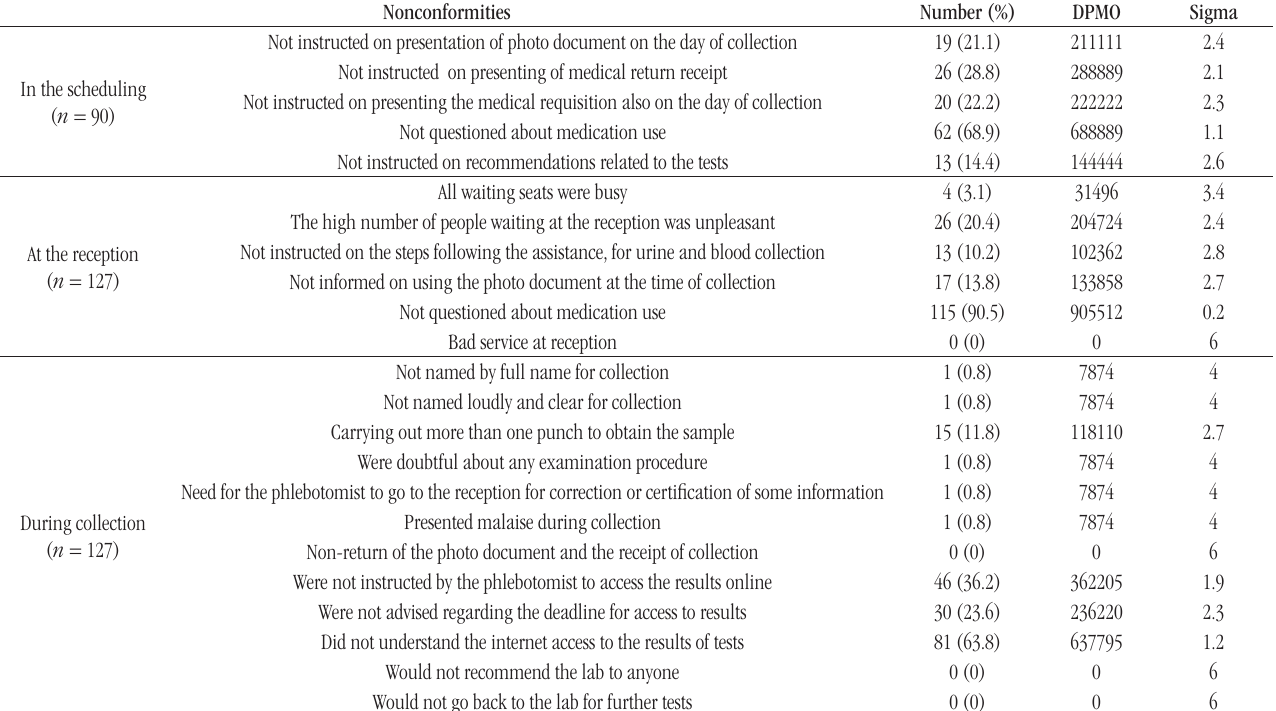
taBLE 4 – Nonconformities found in the laboratory pre-analytical phase according to clients’